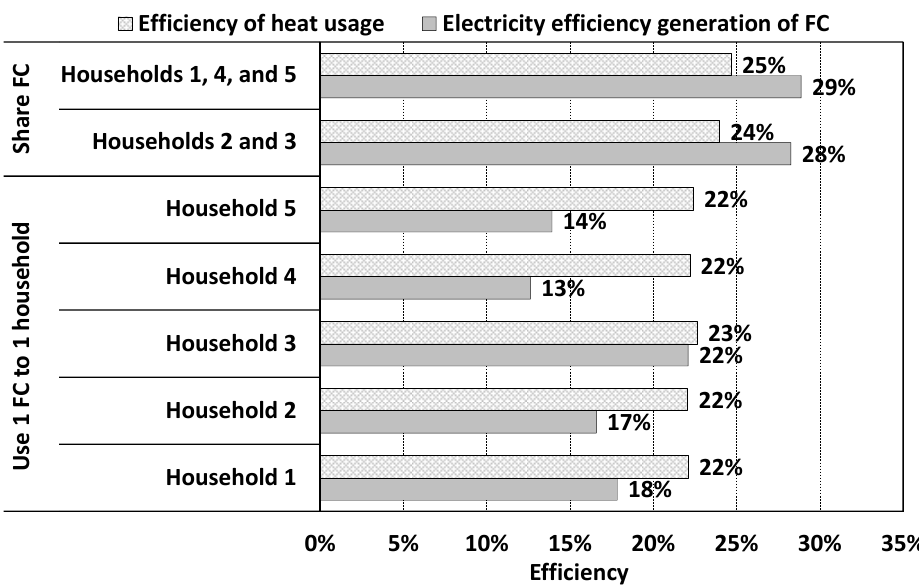
Figure 13. Yearly electricity generation and heat output efficiencies of simulating using one SOFC cogeneration system for one household and multi-households.